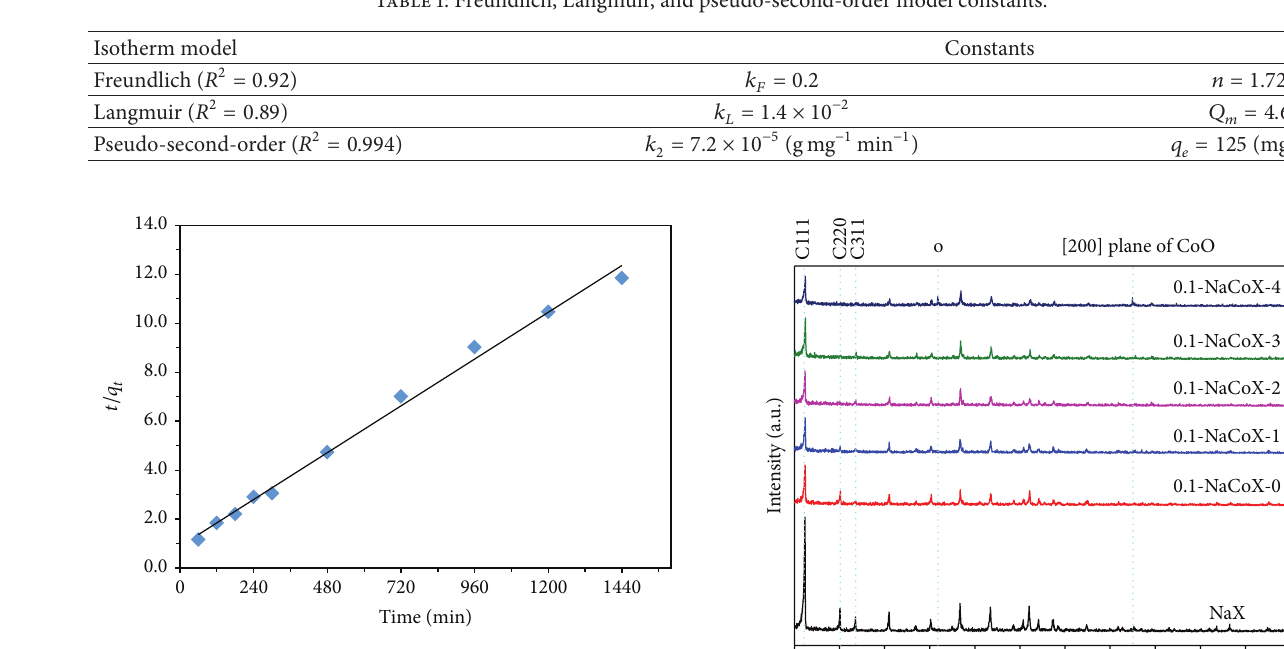
Figure3:Pseudo-second-ordersorptionkineticmodelofcobalt(II) on NaX zeolite.